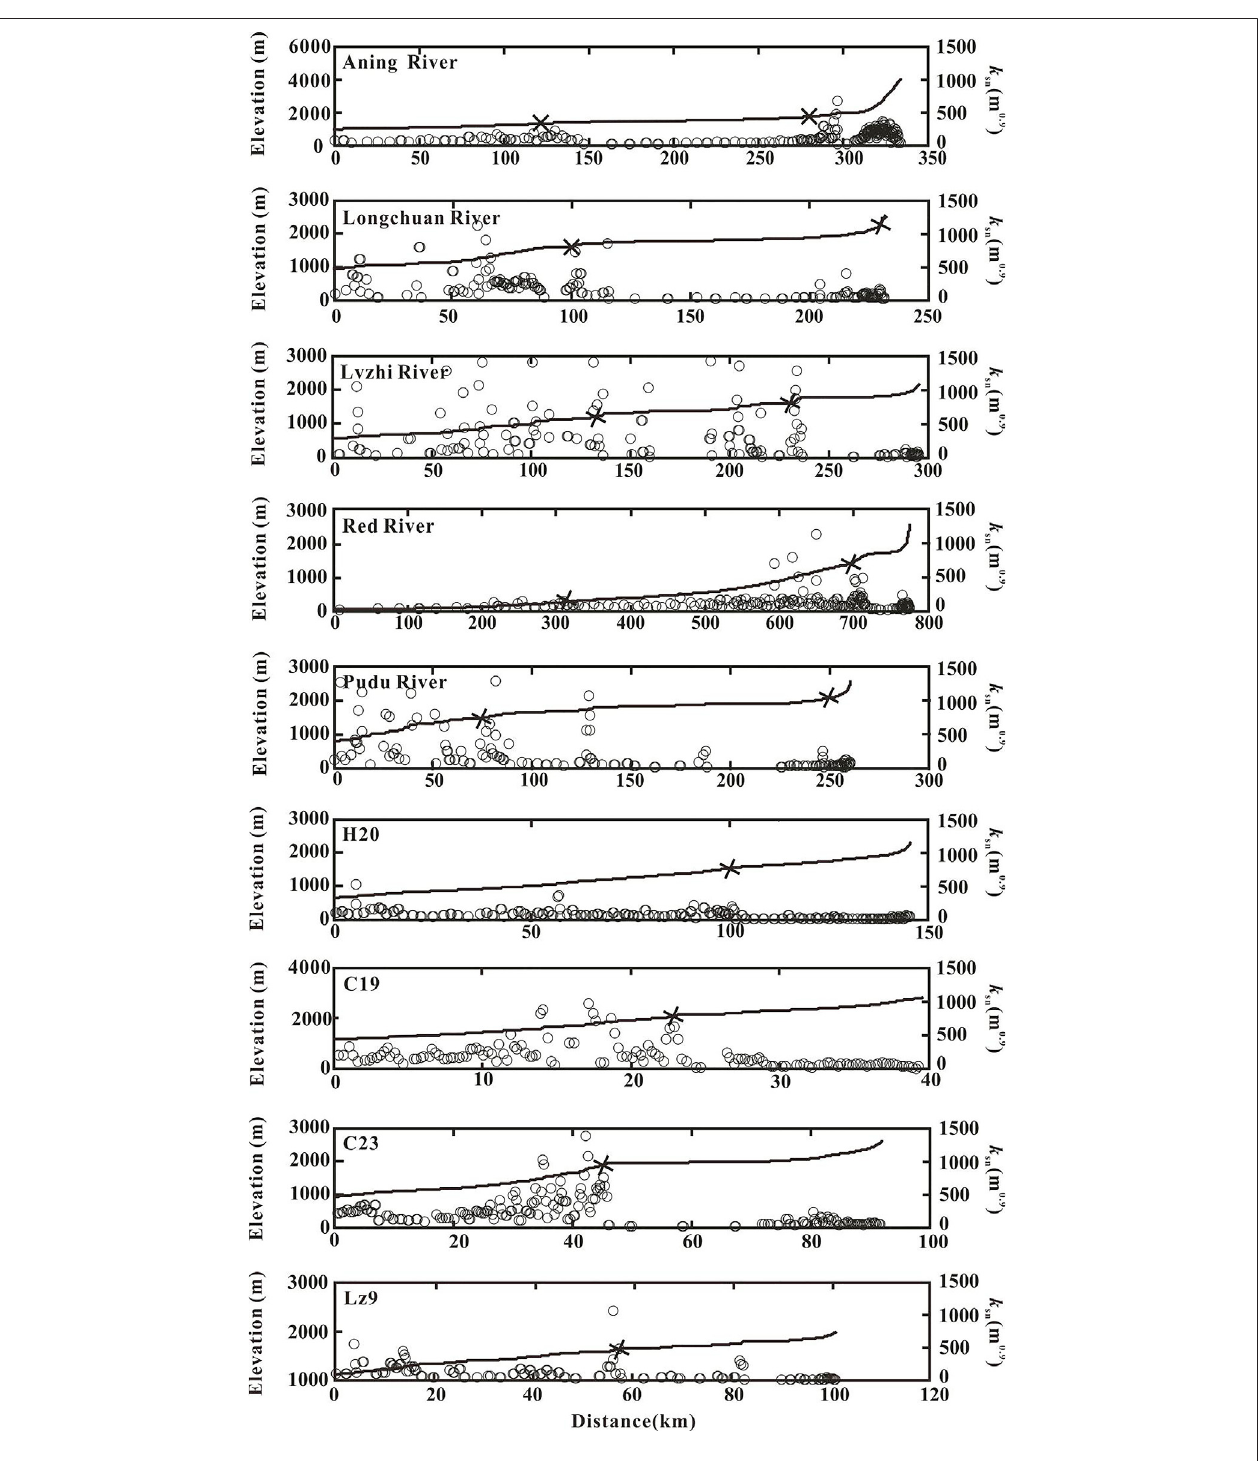
FIGURE 4 | Channel steepness of representative river pro fi les. Black crosses are knickpoints.